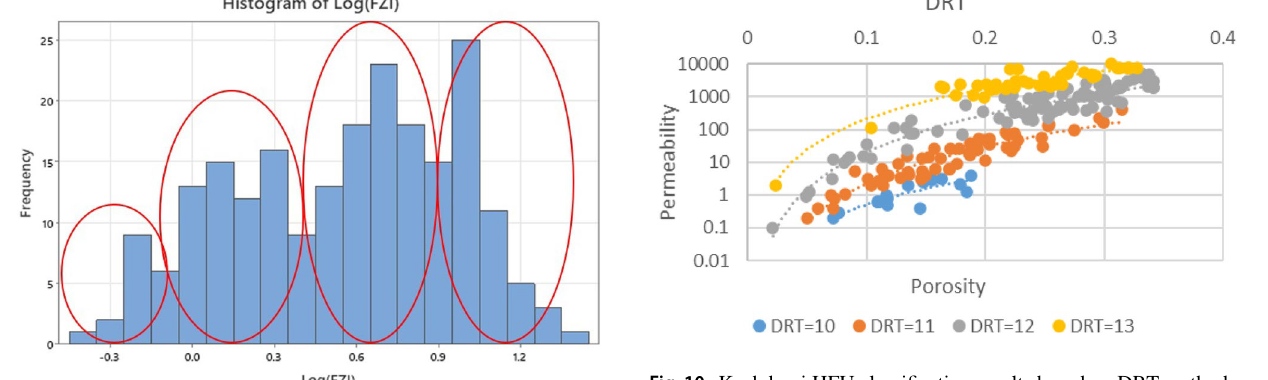
Fig. 10 Kazhdumi HFU classification results based on DRT method